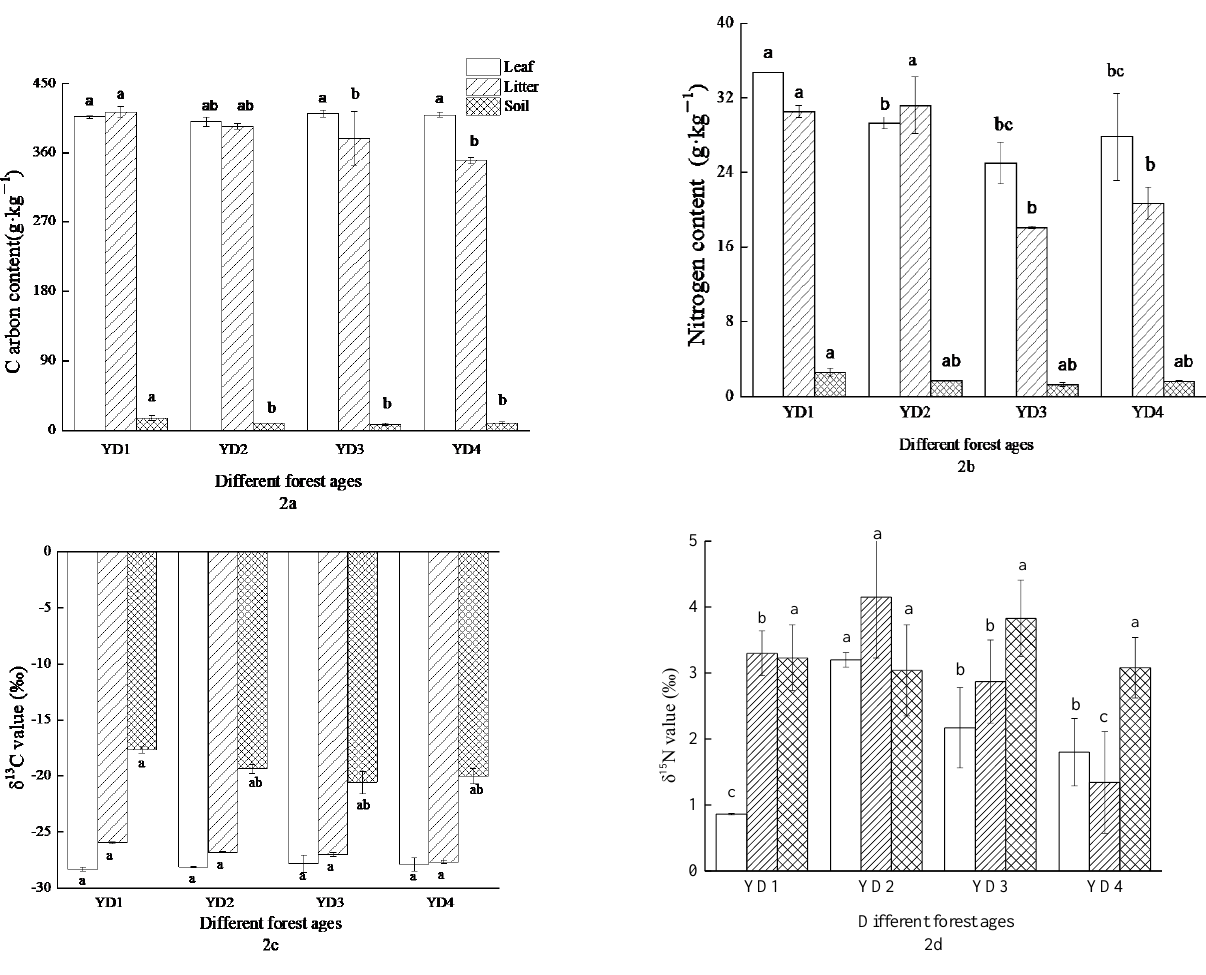
Figure 2. The C, N and their stable isotope characteristics of Zanthoxylum planispinum var. dintanensis with different ages, in carbon content ( a ), nitrogen content ( b ), δ 13 C value ( c ) and δ 15 N value ( d ). Data represent mean ± SD ( n = 3). The different letters indicate significant differences among the age ( p < 0.05). YD1, YD2, YD3, and YD4 represent four different forest ages (5–7, 10–12, 20–22, and 30–32), respectively. The C, N and their stable isotope correlation in Zanthoxylum planispinum var. dintanensis